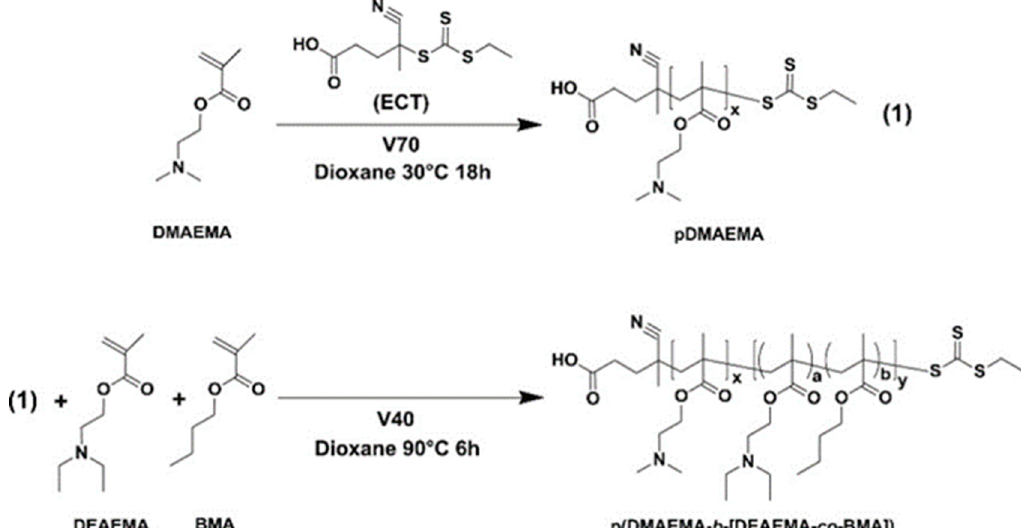
Figure 9. Preparation of a representative copolymer consisting of a cationic poly(DMAEMA) (dimethylaminoethyl methacrylate) block and an endosomolytic hydrophobic block incorporating DEAEMA and butyl methacrylate (BMA) at varying molar feed ratios. Reproduced with permission from Matthew J. Manganiello, Connie Cheng, Anthony J. Convertine, James D. Bryers, and Patrick S. Stayton. Biomaterials; published by Elsevier, 2012.